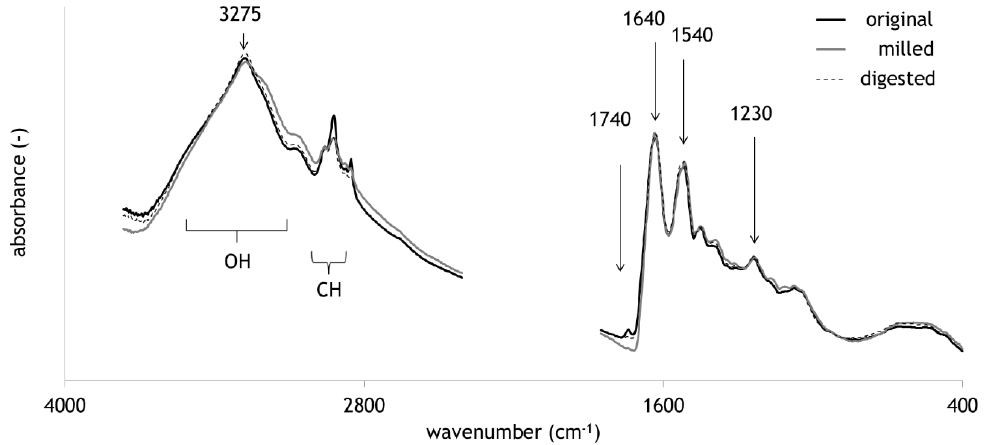
Figure 1. Average spectra of the three sample sets with important band regions and specific maxima. Table 1. Band assignment of hair spectra, wavenumbers in cm −1 . Band Region.